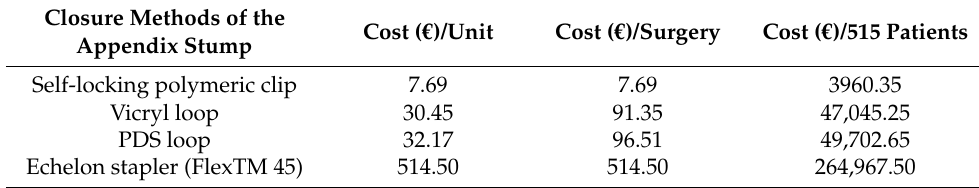
Table 5. Cost of different closure methods of appendix